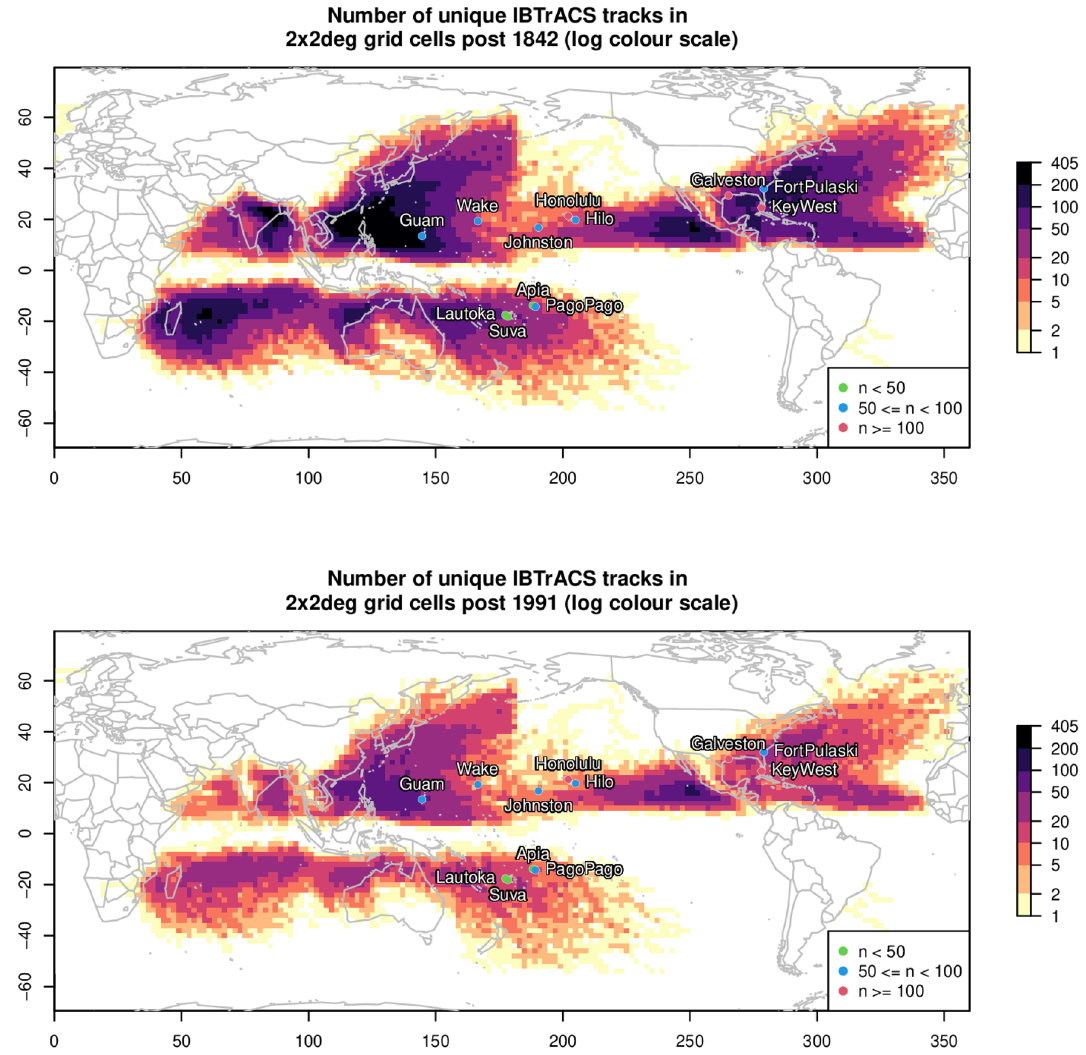
Figure 1. Maps showing location record length (n years) of tide gauges used in this study overlayed on the gridded storm track density (coloured by number of storms, log colour scale) in the IBTrACs v04r00 dataset. Top: track count since 1842, bottom: track count since